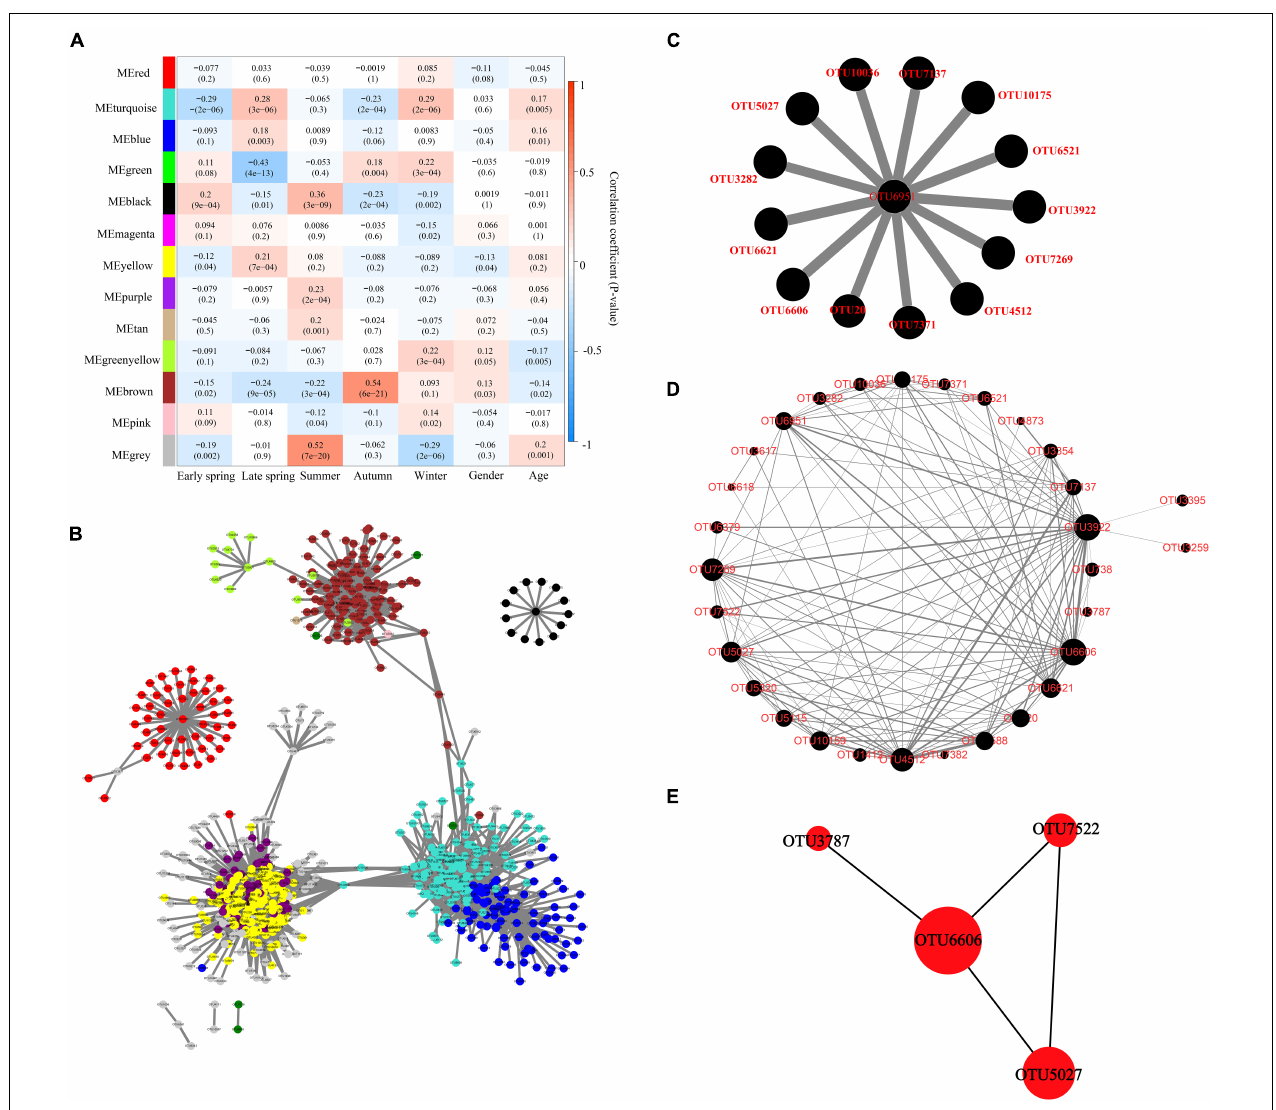
FIGURE 5 | Identification of key module and hub OTUs based on WGCNA. (A) Correlation between module eigenvalue and traits of musk deer. Depth of color corresponds to depth of correlation and p -value of each module presented in parentheses. (B) Network diagram of the hub OTUs. Each node represented the OTUs whose Ktotal value was in the top 10%, and its color represented the corresponding module. The gray line thickness represents the weight value between nodes (OTUs). (C) Visualization of hub OTUs in black modules. (D) Visualization of full weighted networks in black modules associated with different seasons. The node size represented the Kwithin value of the node in the black module, that is, the size of the connectivity in the module. The gray line thickness represented the weight value between nodes (OTUs). (E) Identification of key OTU in the black module through Cytohubba. The node size represented the Kwithin value, and the shade of red indicated the importance within the